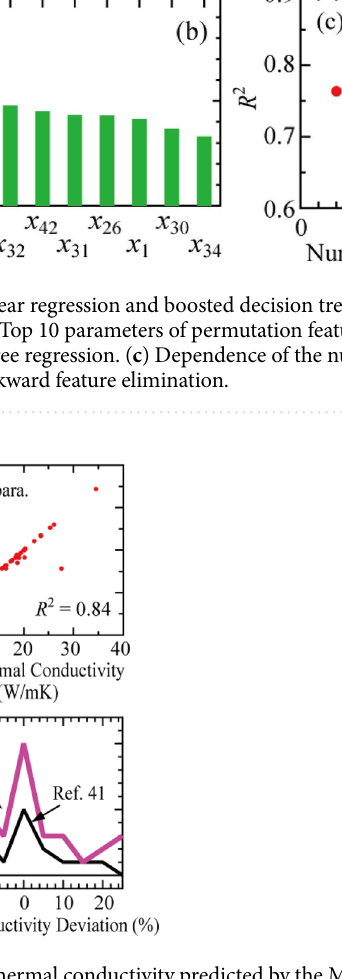
Figure 4. ( a , b ) Comparison between the lattice thermal conductivity predicted by the ML model of boosted decision tree regression using 55, and 4 parameters and the lattice thermal conductivity calculated by the DFT calculation. ( c ) Number of deviations between the predicted and calculated lattice thermal conductivity using 55 and 4 parameters. ( d ) Number of deviations between the predicted and calculated lattice thermal conductivity reported by Carrete et al. 41 and Liu et al. 42